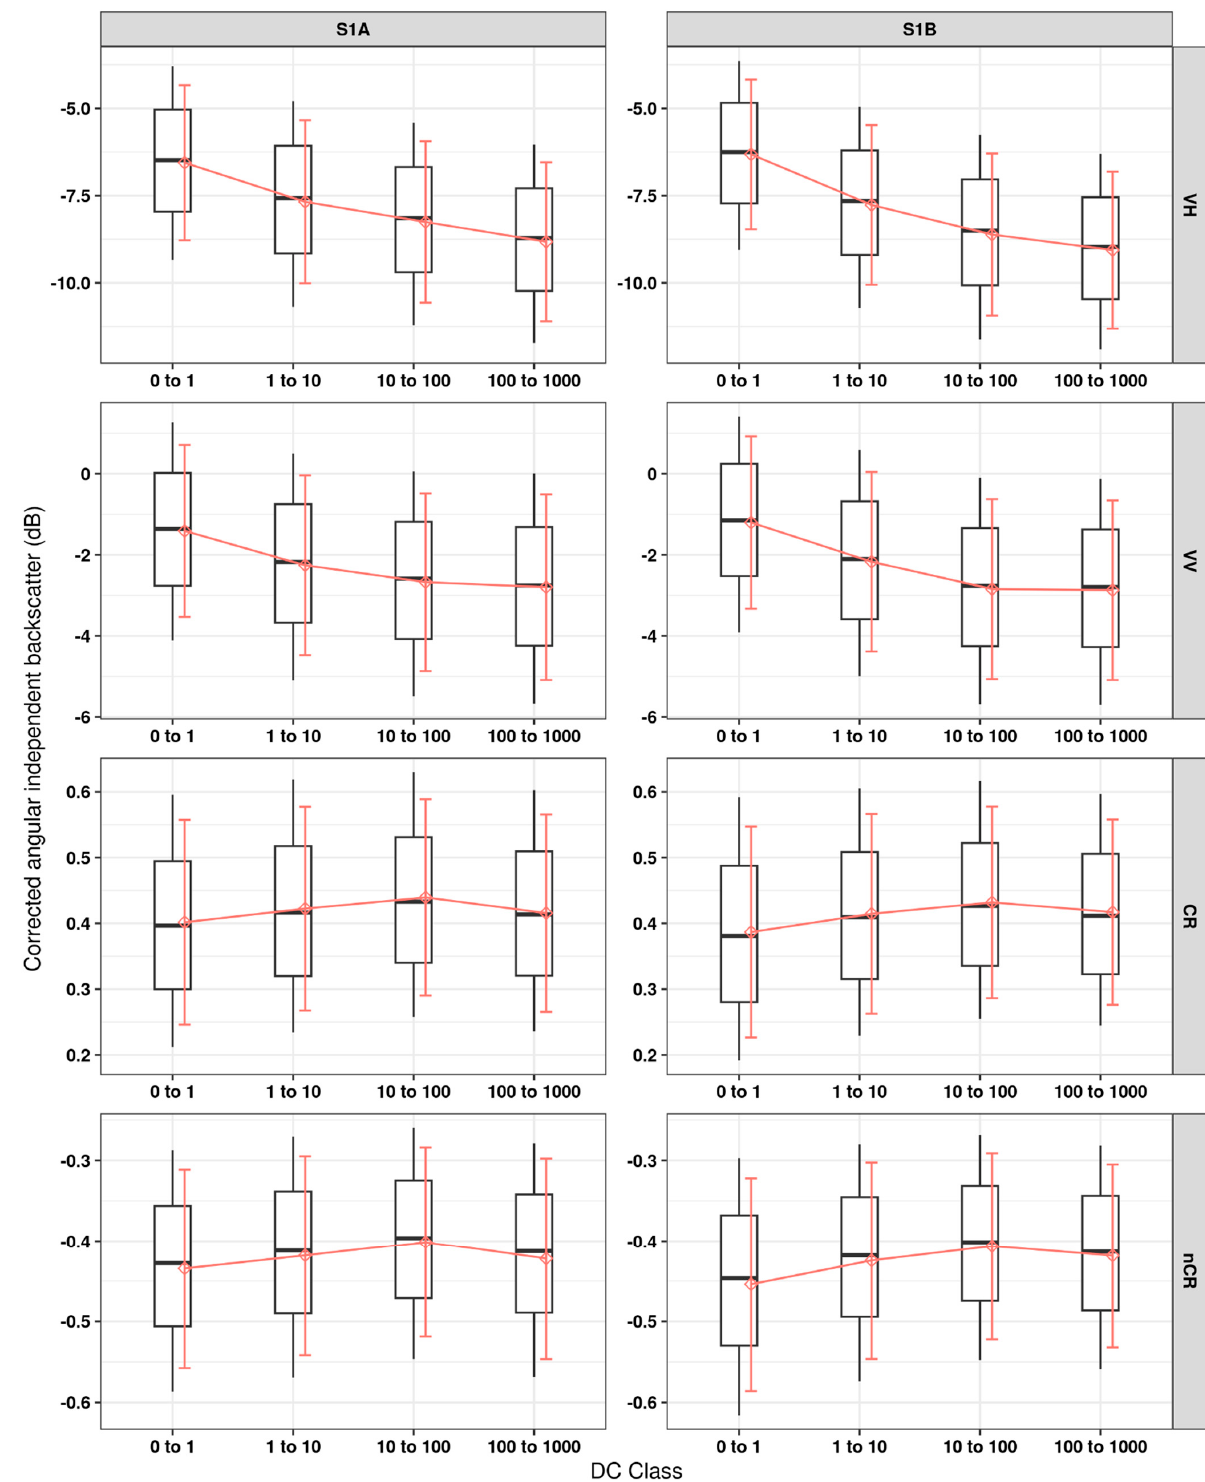
Figure 7. Distribution of corrected backscatter values in unburnt pixels with the DC classes for the two polarizations (VV and VH) and for the cross-ratio (CR)-VH/VV and normalized cross-ratio (nCR) (VV-VH)/(VV+VH)). Red lines connect the average values, red whiskers are standard deviation, boxplots are the medians and interquartile ranges, with whiskers corresponding to the 10th and 90th percentile.